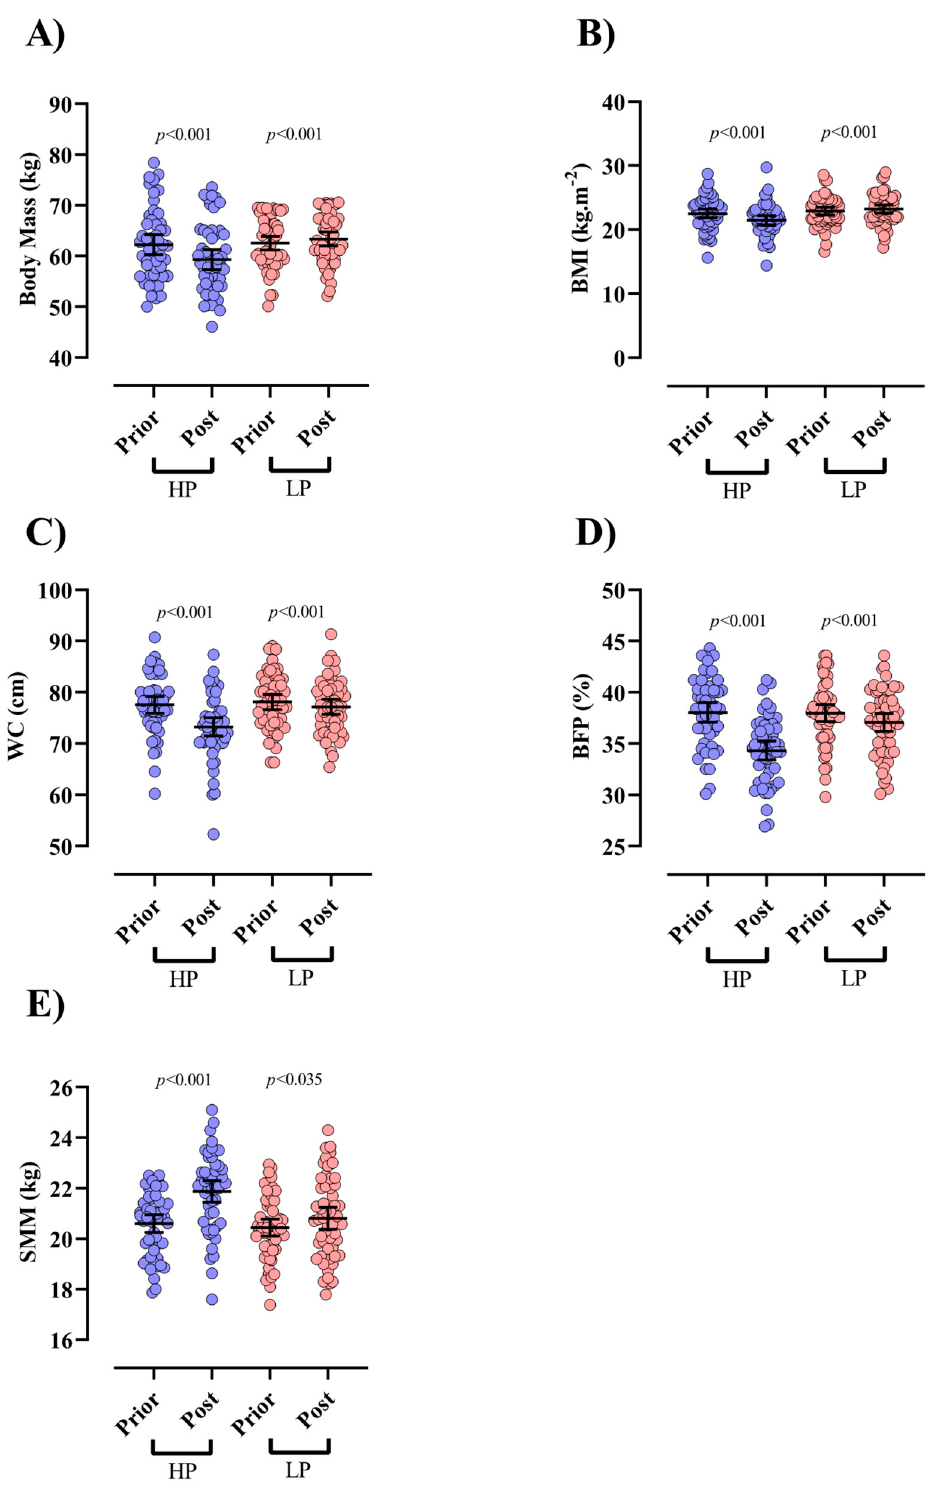
Figure 2. The effects of HP and LP interventions on body composition variables. ( A ) Body Mass, ( B ) BMI: body mass index, ( C ) WC: waist circumference, ( D ) BFP: body fat percentage, ( E ) SMM. Error bars indicate 95% CI. P-values of t-test are indicated above each group.